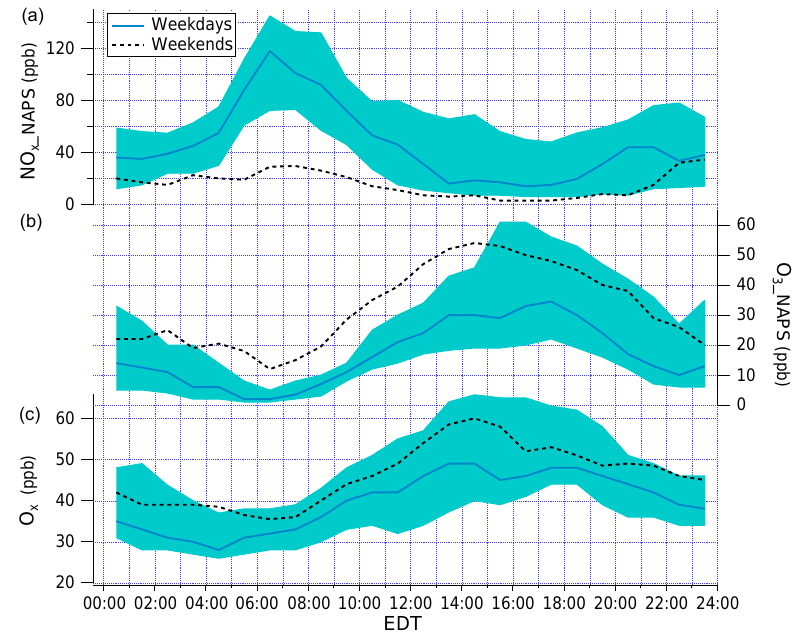
Figure 9. Average weekday and weekend diurnal cycles of mixing ratios of NO x (a) , O 3 (b) , and O x (c) from the NAPS for the 16-day study period. Solid green lines are medians and the shaded areas are the interquartile ranges on weekdays; dashed black lines are medians on weekends.